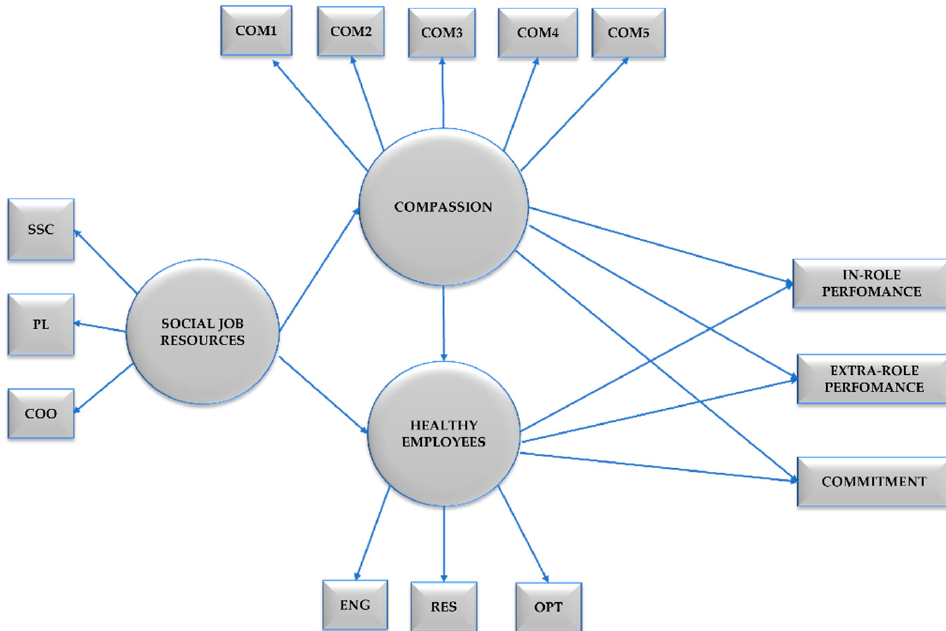
Figure 1. Research model involving Compassion, Social Job Resources, Healthy Employees and Healthy Organisational Outcomes. Note. SSC = Social Support Climate, PL = Positive Leadership, COO = Coordination, COM1 = Compassion Item 1, COM2 = Compassion Item 2, COM3 = Compassion Item 3, COM4 = Compassion Item 4, COM5 = Compassion Item 5, ENG = Engagement, RES = Resilience, OPT = Optimism.